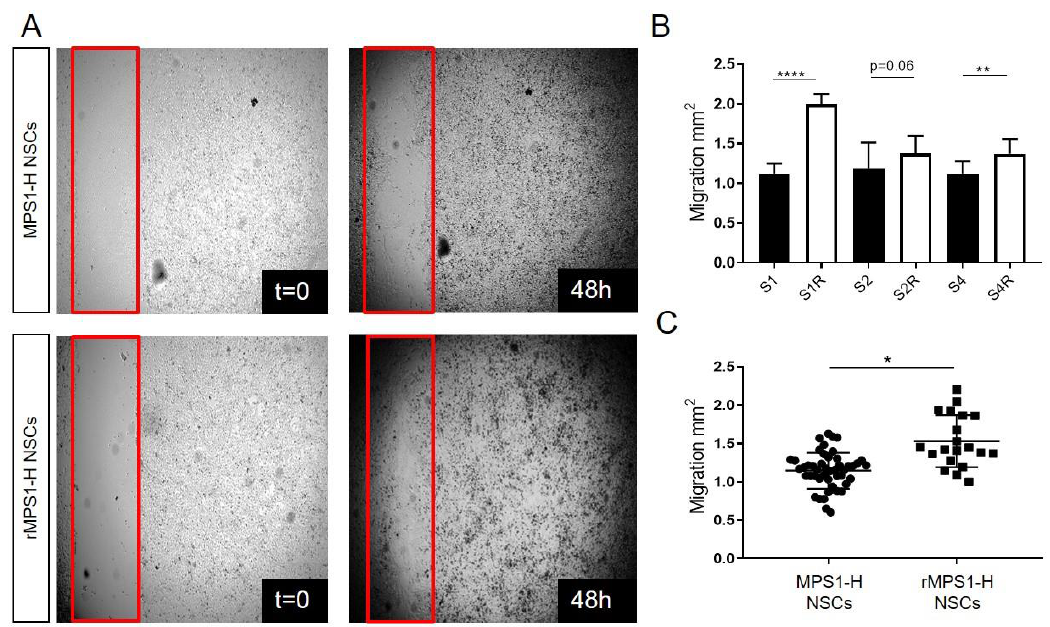
Figure 3. Migration impairment of undifferentiated MPS1-H iPSCs-derived NSCs. ( A ) Acquisitions of MPS1-H and rescued MPS1-H iPSCs-derived NSCs cultures immediately after scratch application ( t = 0) and 48 h later. The red frame shows scratch boundaries. ( B ) Graphic showing the total migration surface over 48 h of different all clones of MPS1-H and rescued MPS1-H iPSCs-derived NSCs. Data are shown as mean ± SEM and were analyzed by independent samples t-test. ** p < 0.01; **** p < 0.001, n = 3. ( C ) Pooled results calculated for MPS1-H iPSCs-derived NSCs vs. rescued ones. Data are shown as mean ± SEM and were analyzed by Welch t-test with Moulton correction, dF = 3.4; t = 5.15. * p = 0.01; ** p < 0.01; **** p < 0.001, n = 3.